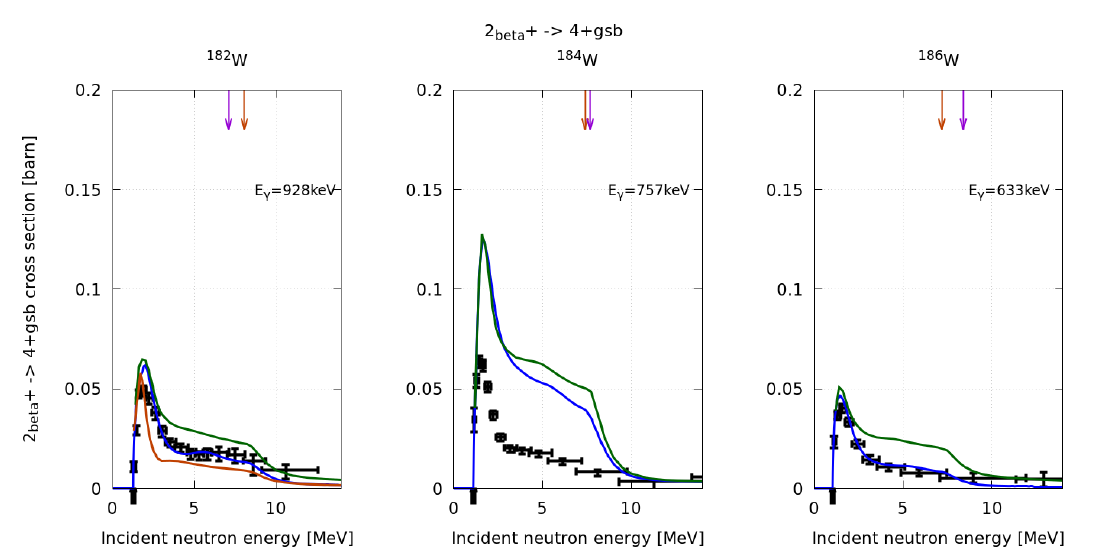
Figure 7. Same as figure 1, for the 2 + from the nat W